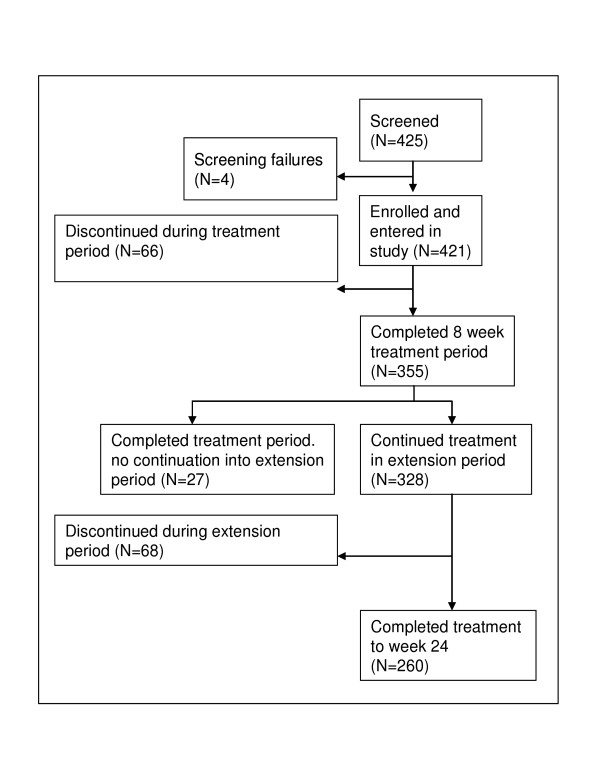
Patient disposition.